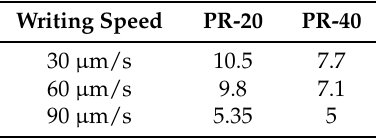
Table 3. Voxel aspect ratio for a laser power of 6.6 mW.